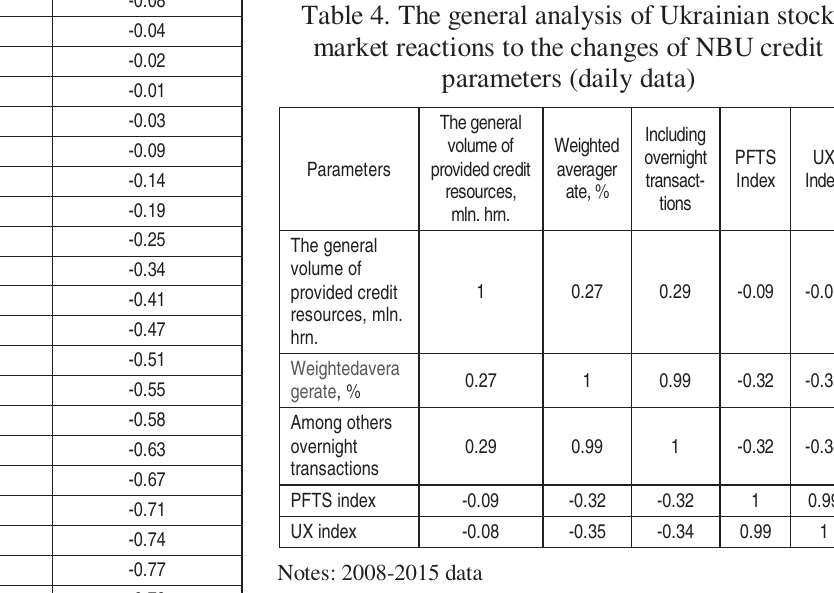
Table 4. The general analysis of Ukrainian